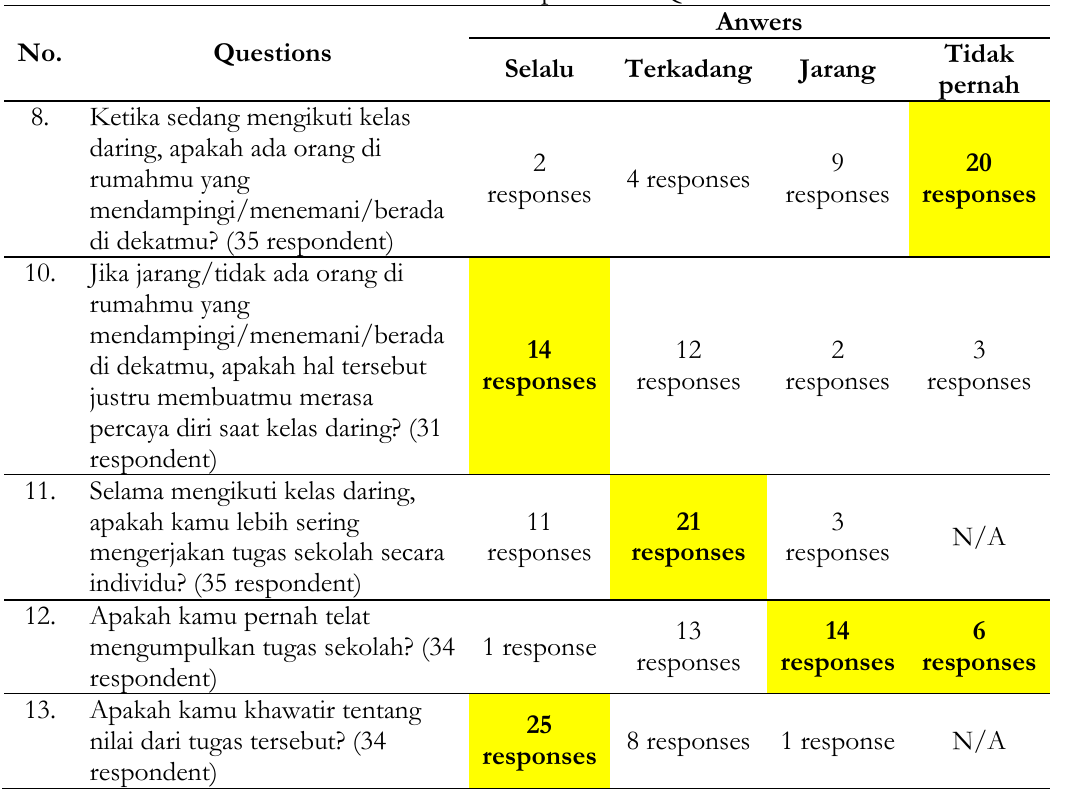
TABLE 3. The 2 nd Topic of the Questions